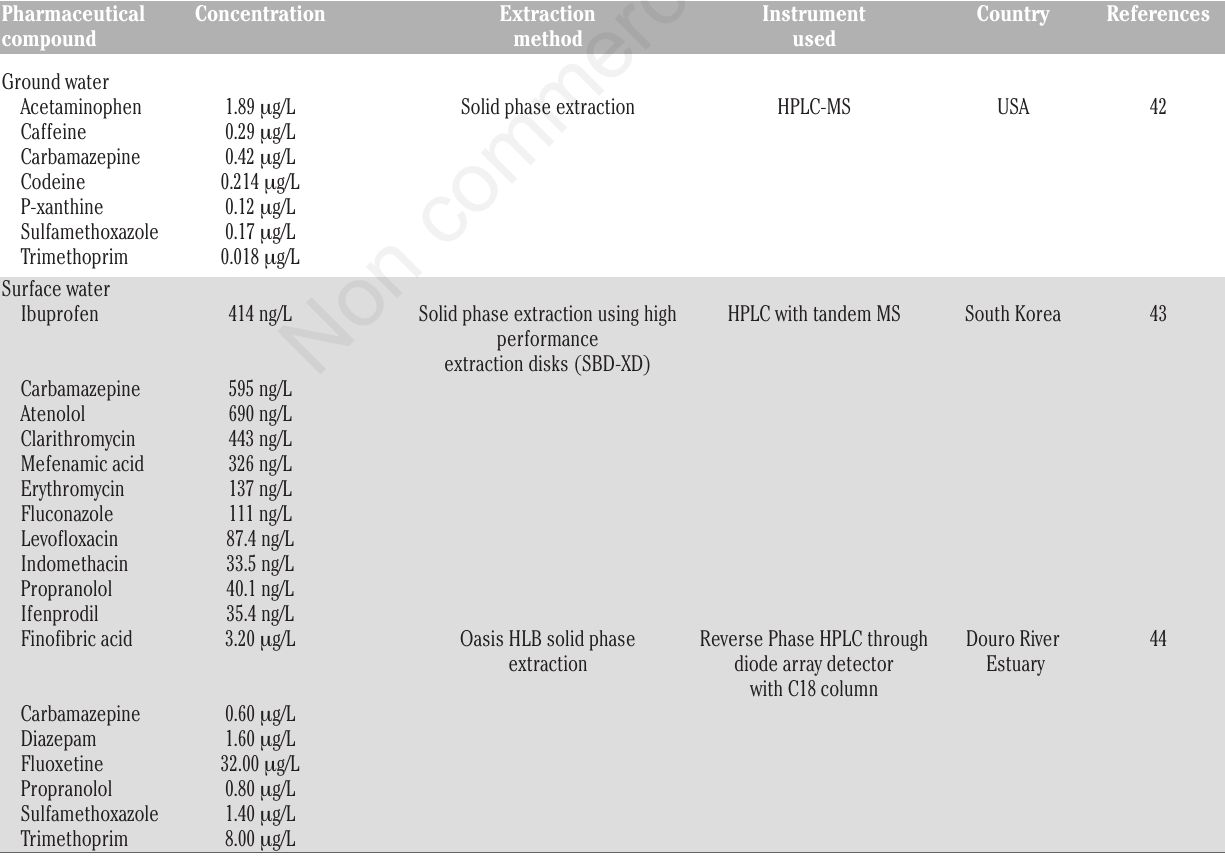
Table 2. Pharmaceutical compounds with detected concentrations in different water bodies with their extraction methods.